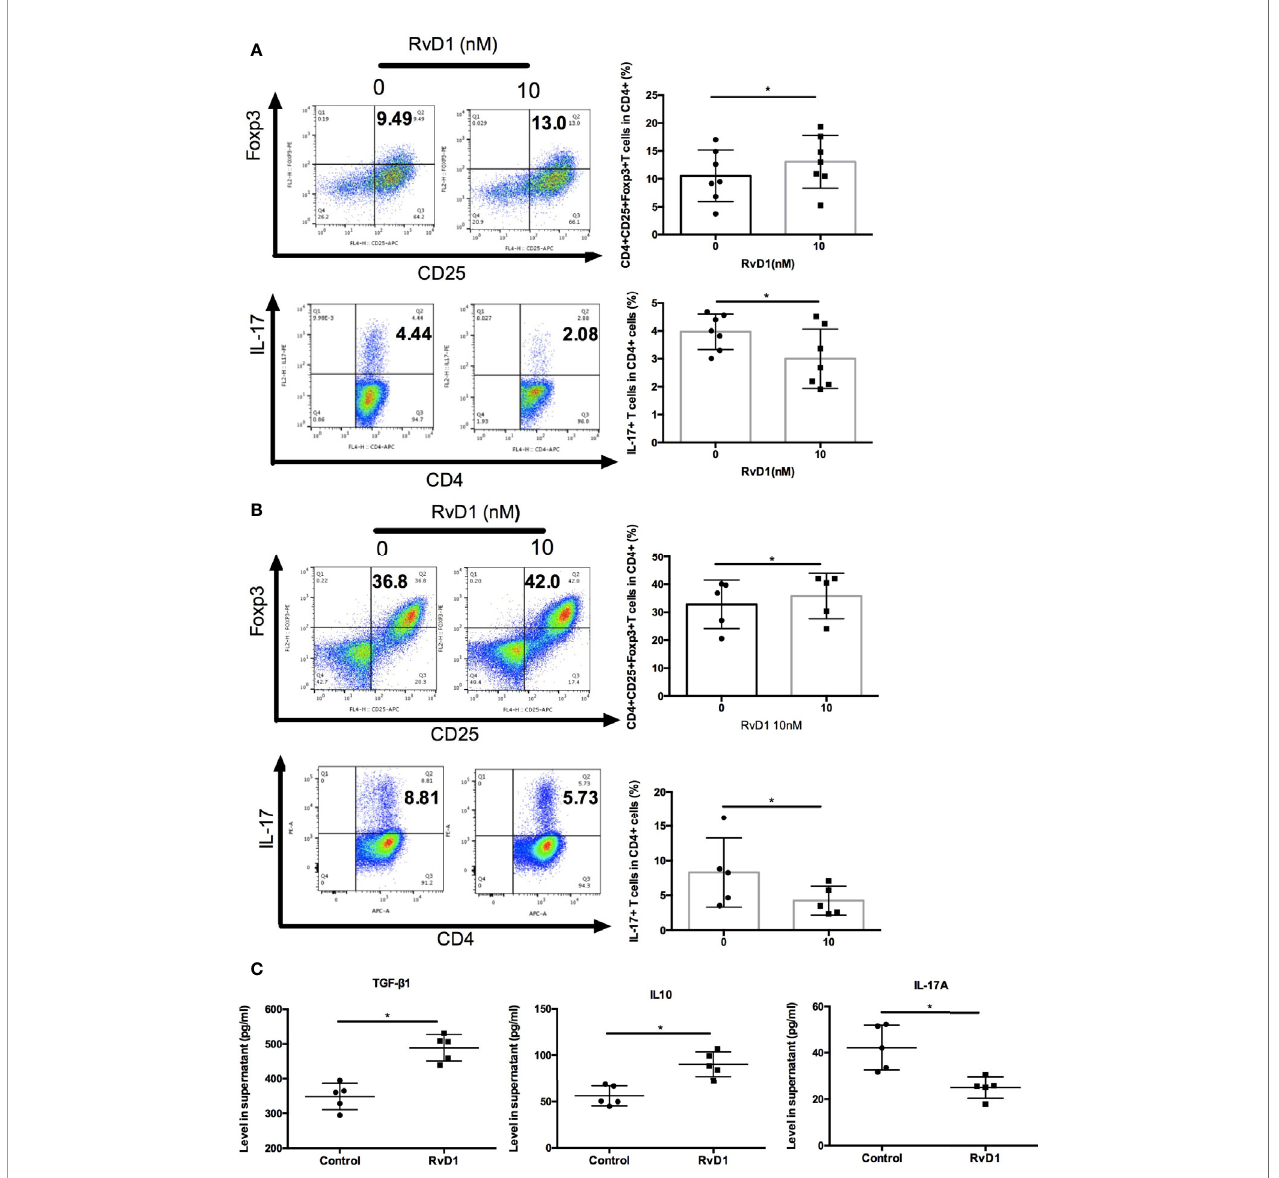
FIGURE 4 | RvD1 modulates the proliferation and differentiation of Treg and Th17 in PBMCs and naïve CD4+ T cells in SLE patients. (A) The percentages of Treg and Th17 in human PBMCs with and without RvD1 treatment (n=7). (B) Flow cytometric analysis of Treg and Th17, which were differentiated from human naïve CD4+ T cells in the presence or absence of RvD1 (n=5). (C) The level of TGF- b , IL-10, and IL-17 in the culture supernatant were detected by ELISA (n=5). All data are mean ± SEM. * p <